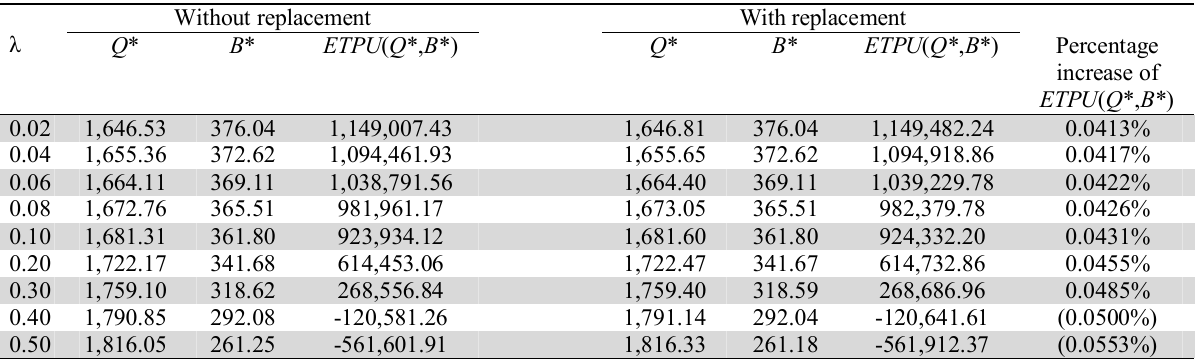
c = 500, c = 100, β= 0.04; η = 0.04 a r